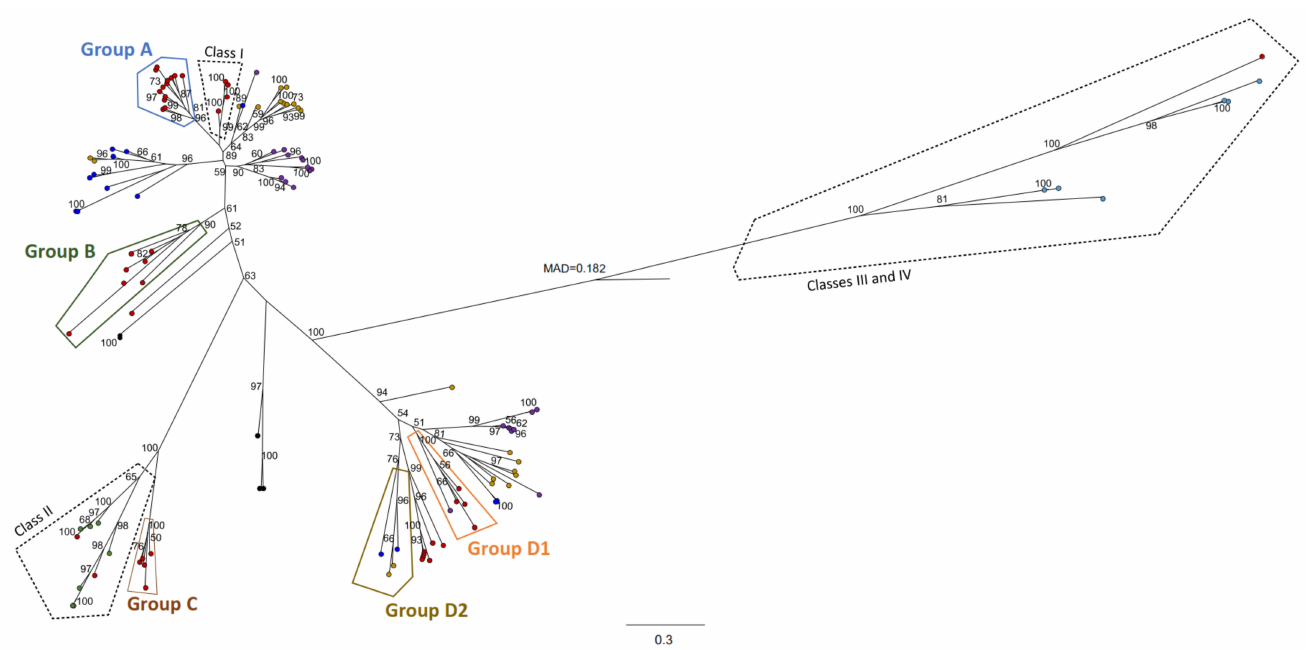
Figure 6. Maximum likelihood phylogenetic tree of PhaC homologues from bacteria of the order Burkholderiales . Each amino acidic sequence is represented with a circle. PHA synthases from ( • ) Burkholderiaceae , ( • ) Alcaligenaceae , ( • ) Comamonadaceae and ( • ) Oxalobacteraceae , class II PHA synthases from ( • ) Pseudomonas , class III and IV PHA synthases from ( • ) Bacillus , Synechocystis , Allochromatium , Rubrobacter and Alcanivorax . Classes I-IV PHA synthases were included for comparison. Sequences were retrieved by BlastP from IMG database using class I PHA synthase from C. necator H16 as the query. Aminoacidic sequences were aligned with a progressive method (MAFFT software) and manually edited. Tree was constructed with Maximum likelihood algorithm (RaXML software), LG+G+I+F substitution model, 1000 bootstrap replicates and rooted using Minimal Ancestral Deviation (MAD) method. Groups A, B, C and D correspond to phylogenetic groups defined in Figure